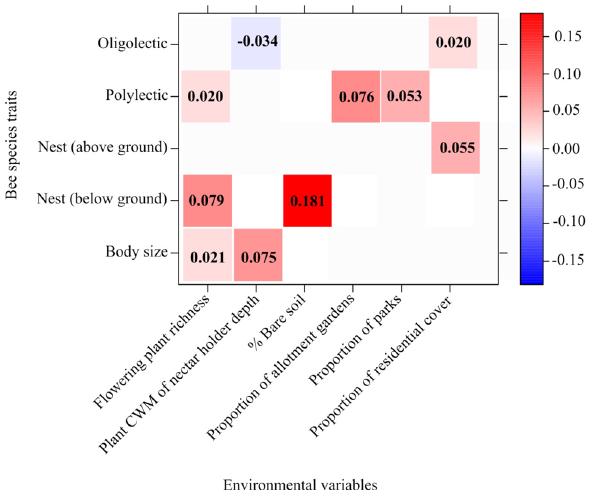
Figure 3. Relationships between bee traits and environmental variables. Red cells indicate positive relationships and blue cells indicate negative relationships. Colour depth indicates the strength of the trait- variable association. Empty cells indicate no relationship. The numbers within red and blue cells correspond to regression